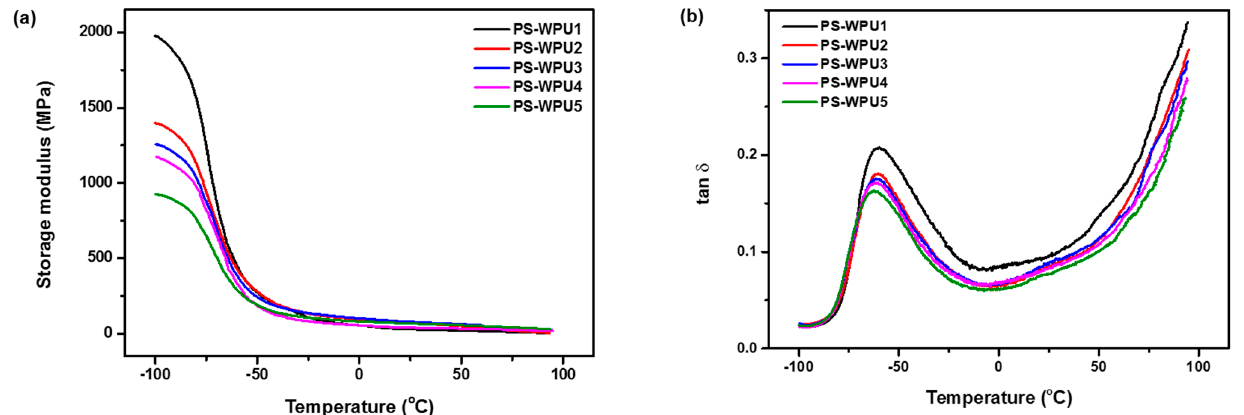
Figure 5. Temperature dependence of ( a ) storage modulus and ( b ) tan δ of PS-WPU samples.